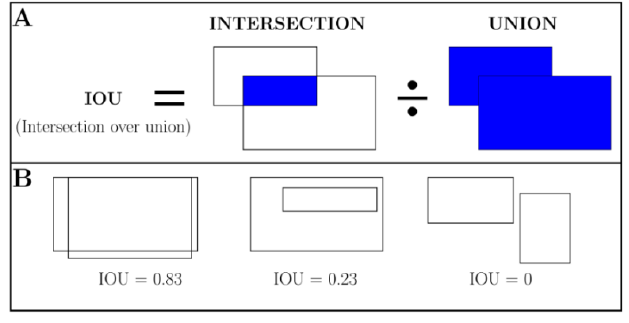
Fig. 6 Intersection over Union (IoU) exemplarily for bounding boxes [17]